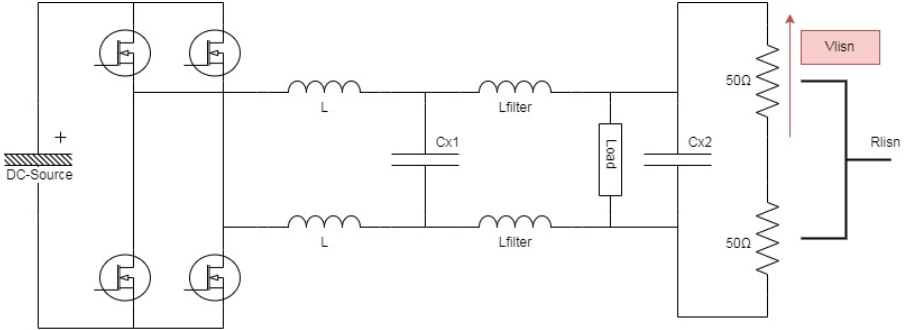
Figure 12. Schematic of a VSI + its differential mode input filter for conducted EMI compliance + the LISN resistors (LISN simplified representation in high frequency range).